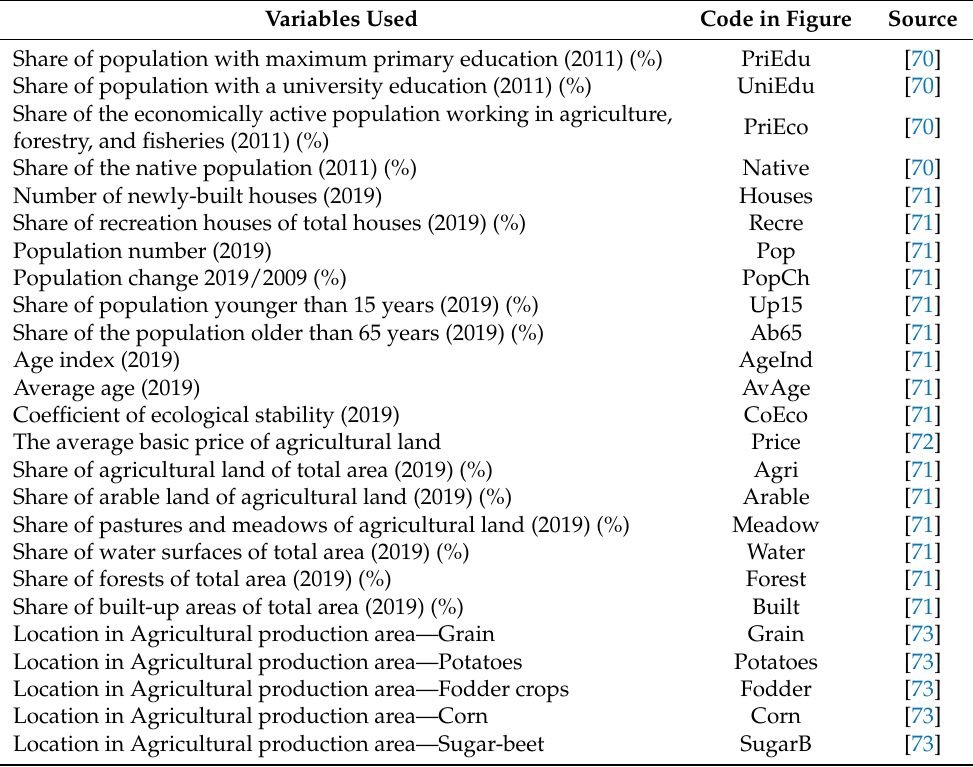
Table 1. Data used as independent variables in the testing of Hypothesis 3 (data on